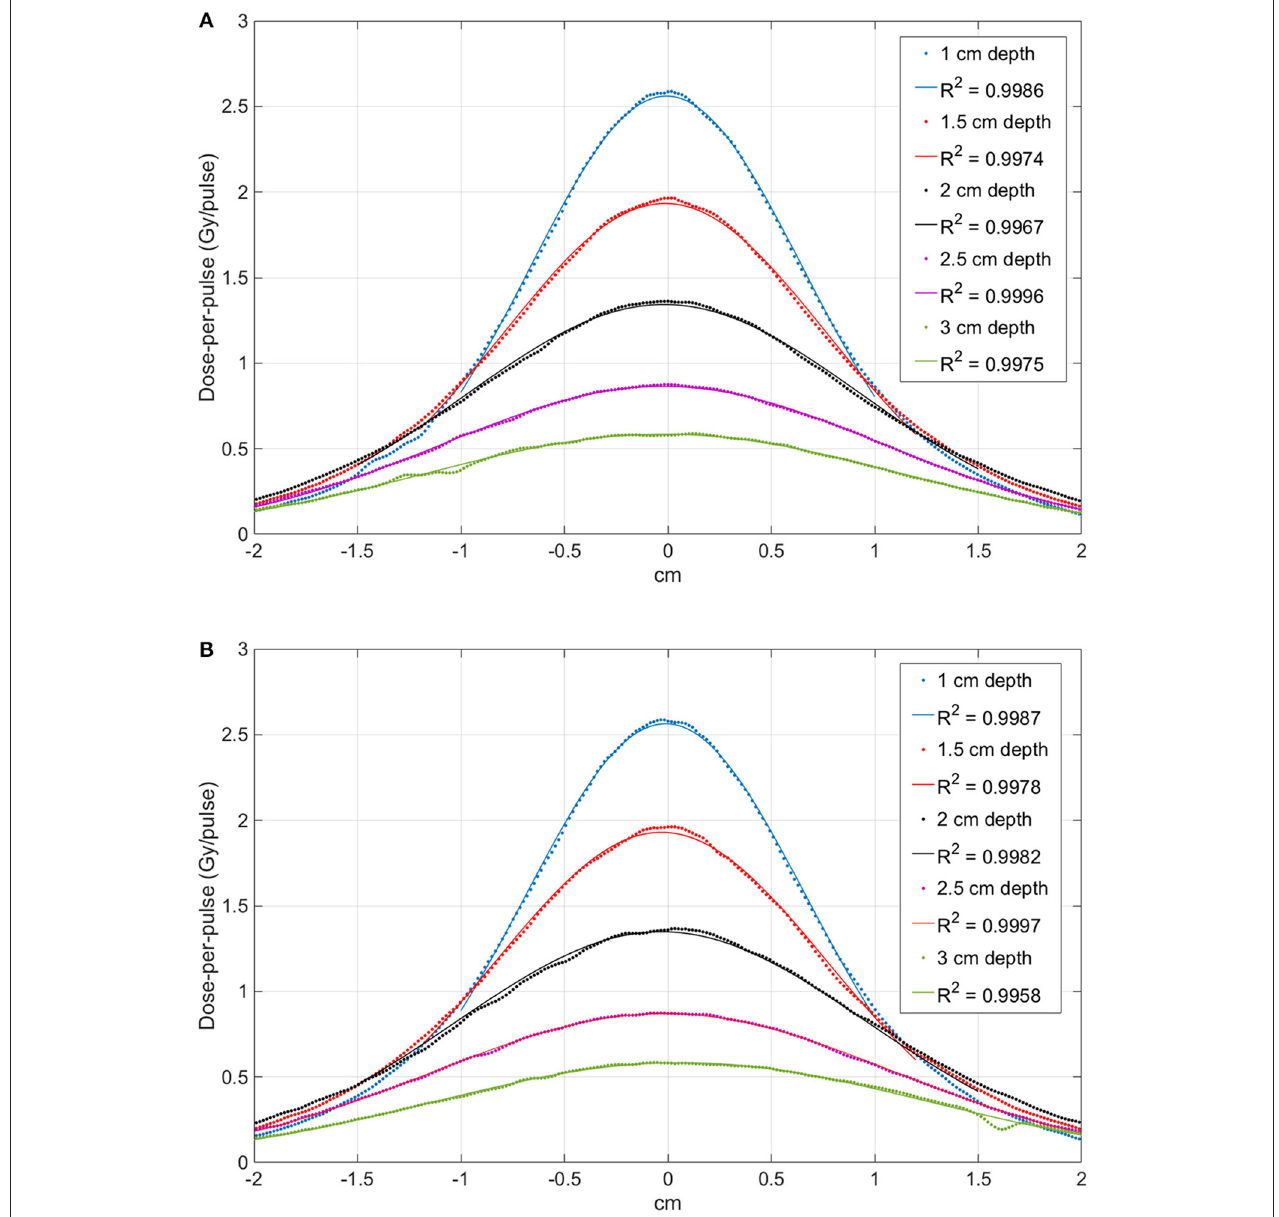
FIGURE 6 | Comparison between the profiles obtained at different depth with the FLASH beam 1. Image (A) shows the X-profiles while image (B) shows the Y-profiles. The superimposed continuous lines show the fit with a Gaussian function; R 2 values are reported for each